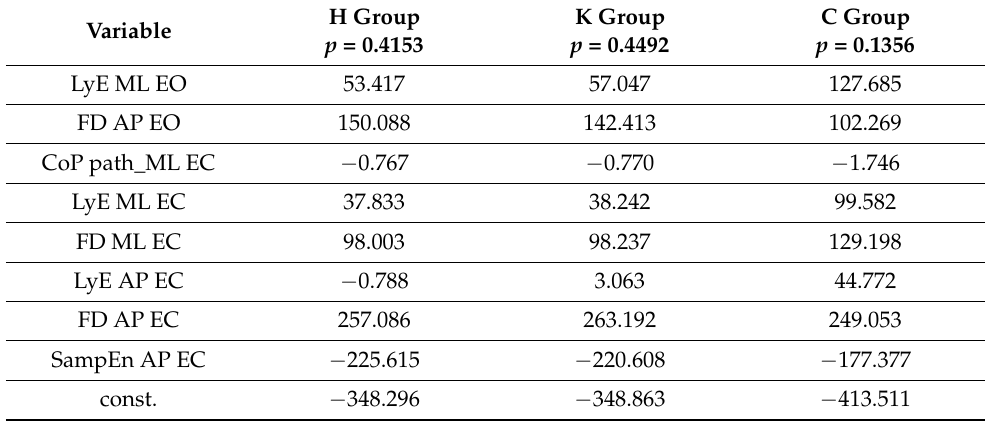
Table 5. Results of the discriminant analysis—classification functions for each